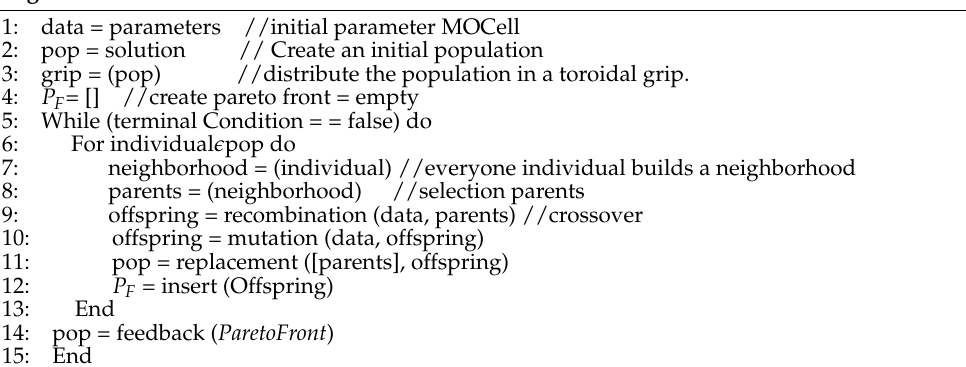
Algorithm 2. Pseudocode of metaheuristic based on MOCell